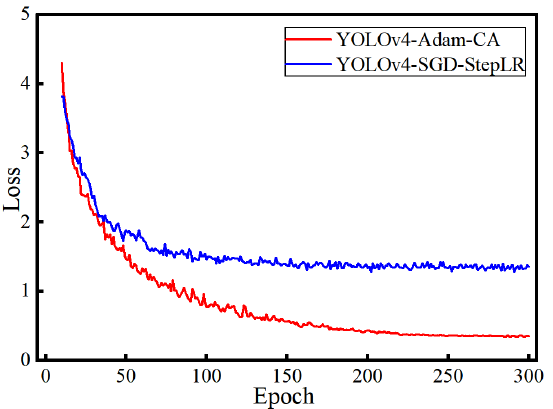
Figure 9. The loss curves of different models during training .